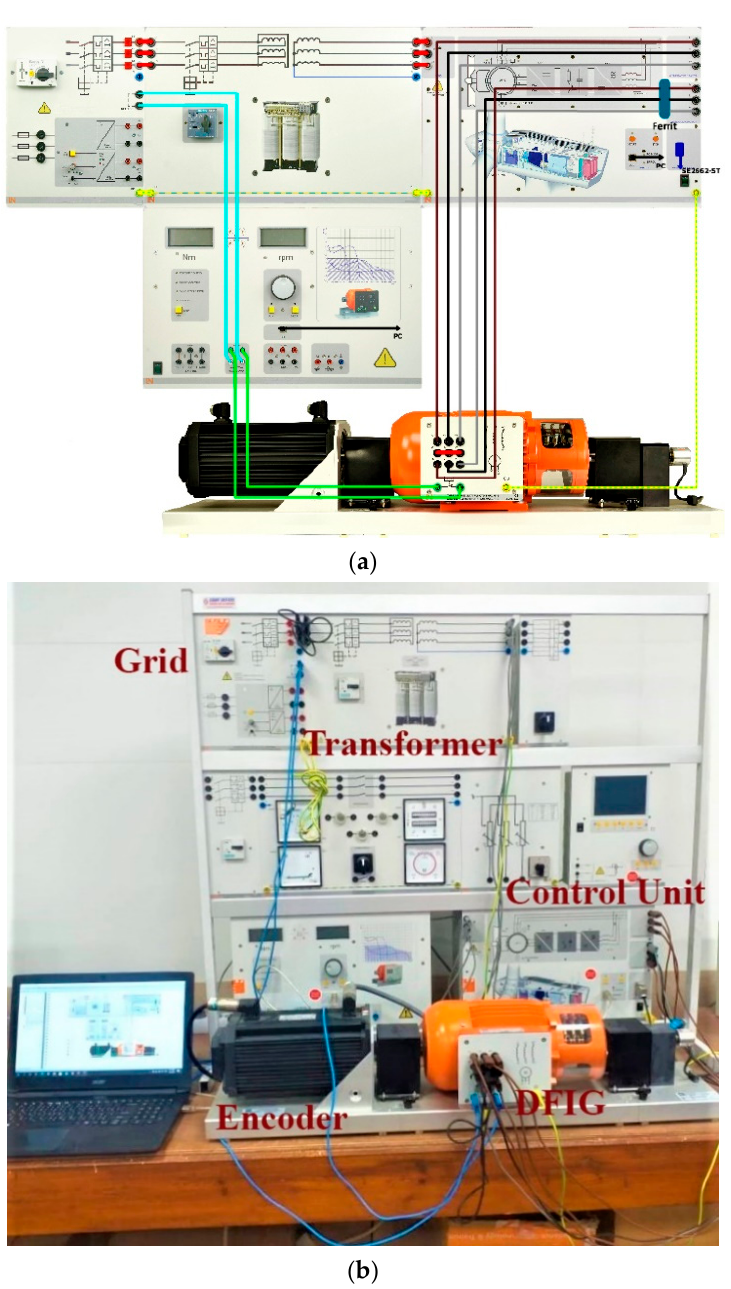
Figure 3. ( a ) Connection diagram of wind power plant. ( b ) Laboratory setup of wind power plant. The wind turbine control unit allows three modes of operation: fixed speed fixed pitch (FSFP), variable speed fixed pitch (VSFP), and variable speed variable pitch (VSVP). The first mode of operation is applied at different wind speeds: 5, 6, and 7 m/s. The blade angle is varied from zero degree to 15 degrees with step size 5 degrees. The active power is directly proportional to the cubic of the velocity. The maximum active power is achieved at zero blade angle and is inversely proportional with the blade angle, as shown in Figure 4a–c.